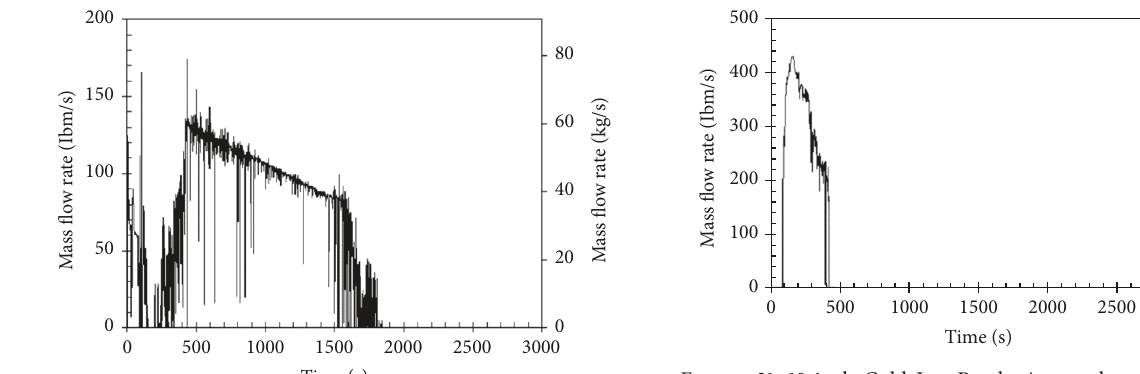
Figure 21: 10-inch Cold Leg Break: Accumulator-1 (NOTRUMP code) [7].